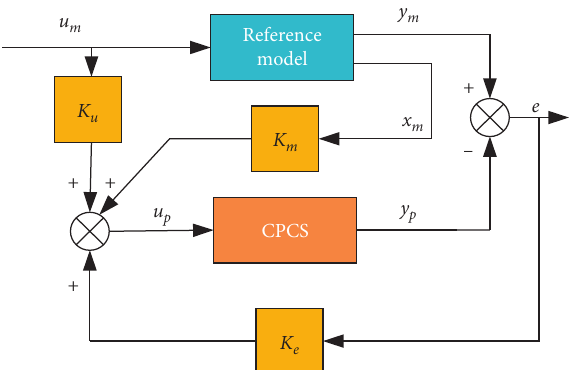
Figure 2: Structure of the SAC-based reconfiguration control